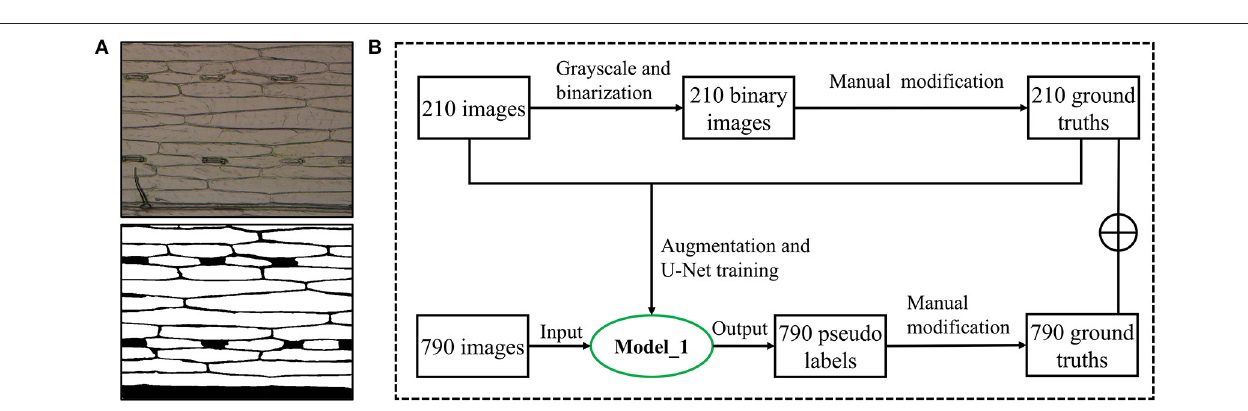
FIGURE 3 | Epidermal cell annotation. (A) Original image of wheat leaf epidermis microscope (upper) and its annotation image (lower). (B) Semiautomatic annotation process using an initial segmentation model (Model_1).